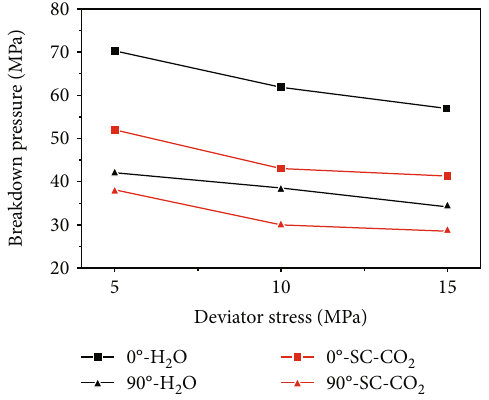
Figure 6: In fl uence of deviator stress on breakdown pressure with bedding plane angles 0 ° and 90 °